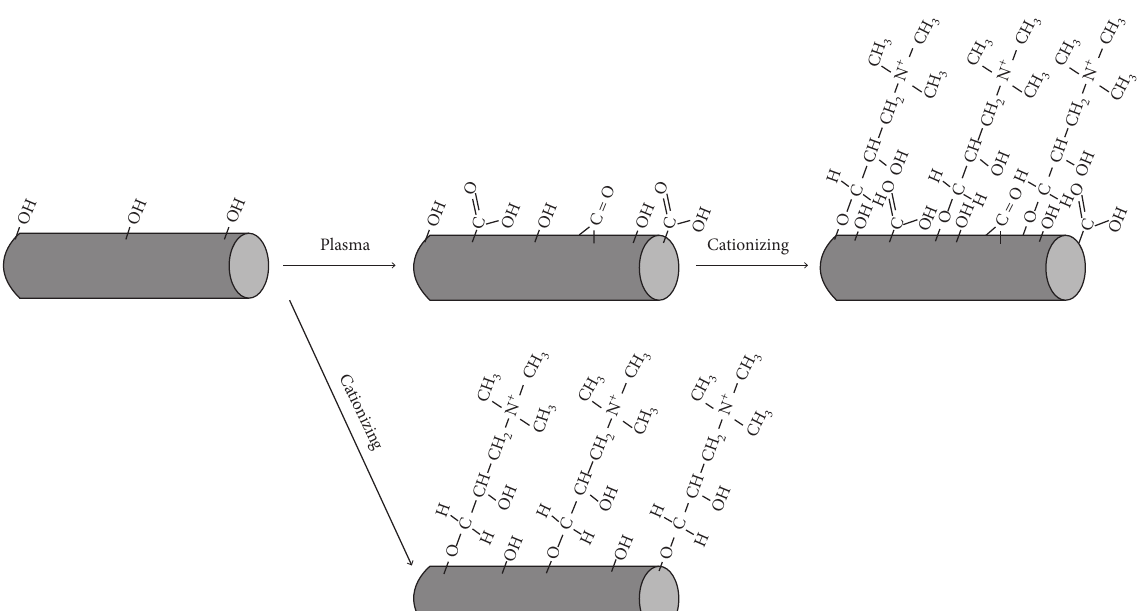
Figure 7: Effects of plasma and cationizing manners in the surface functionalization of the cellulose constituting the cotton fiber